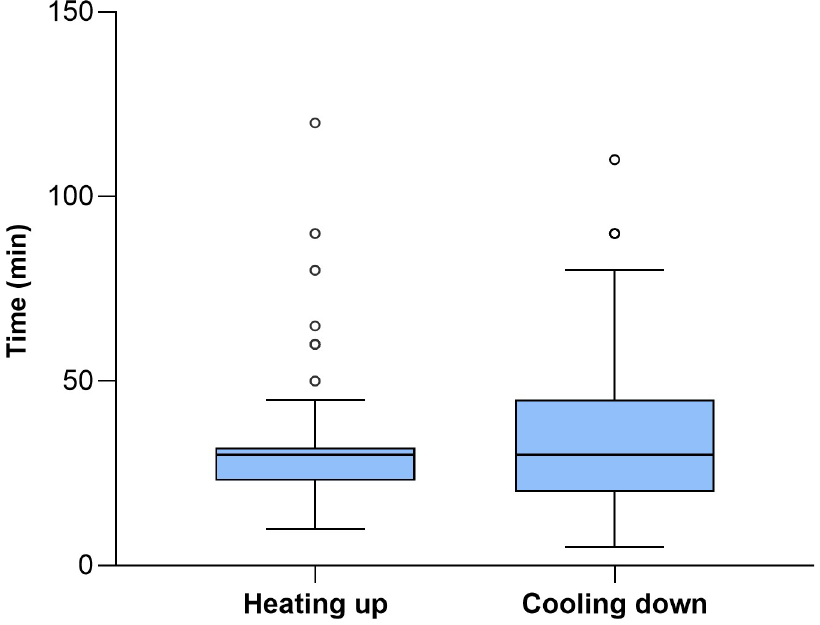
Fig 3. Heating up times to pasteurization temperature (n = 103. “Don’t know”, n = 13) and duration of the cooling cycle (n = 106. “Don’t know/not controlled”, n = 10).